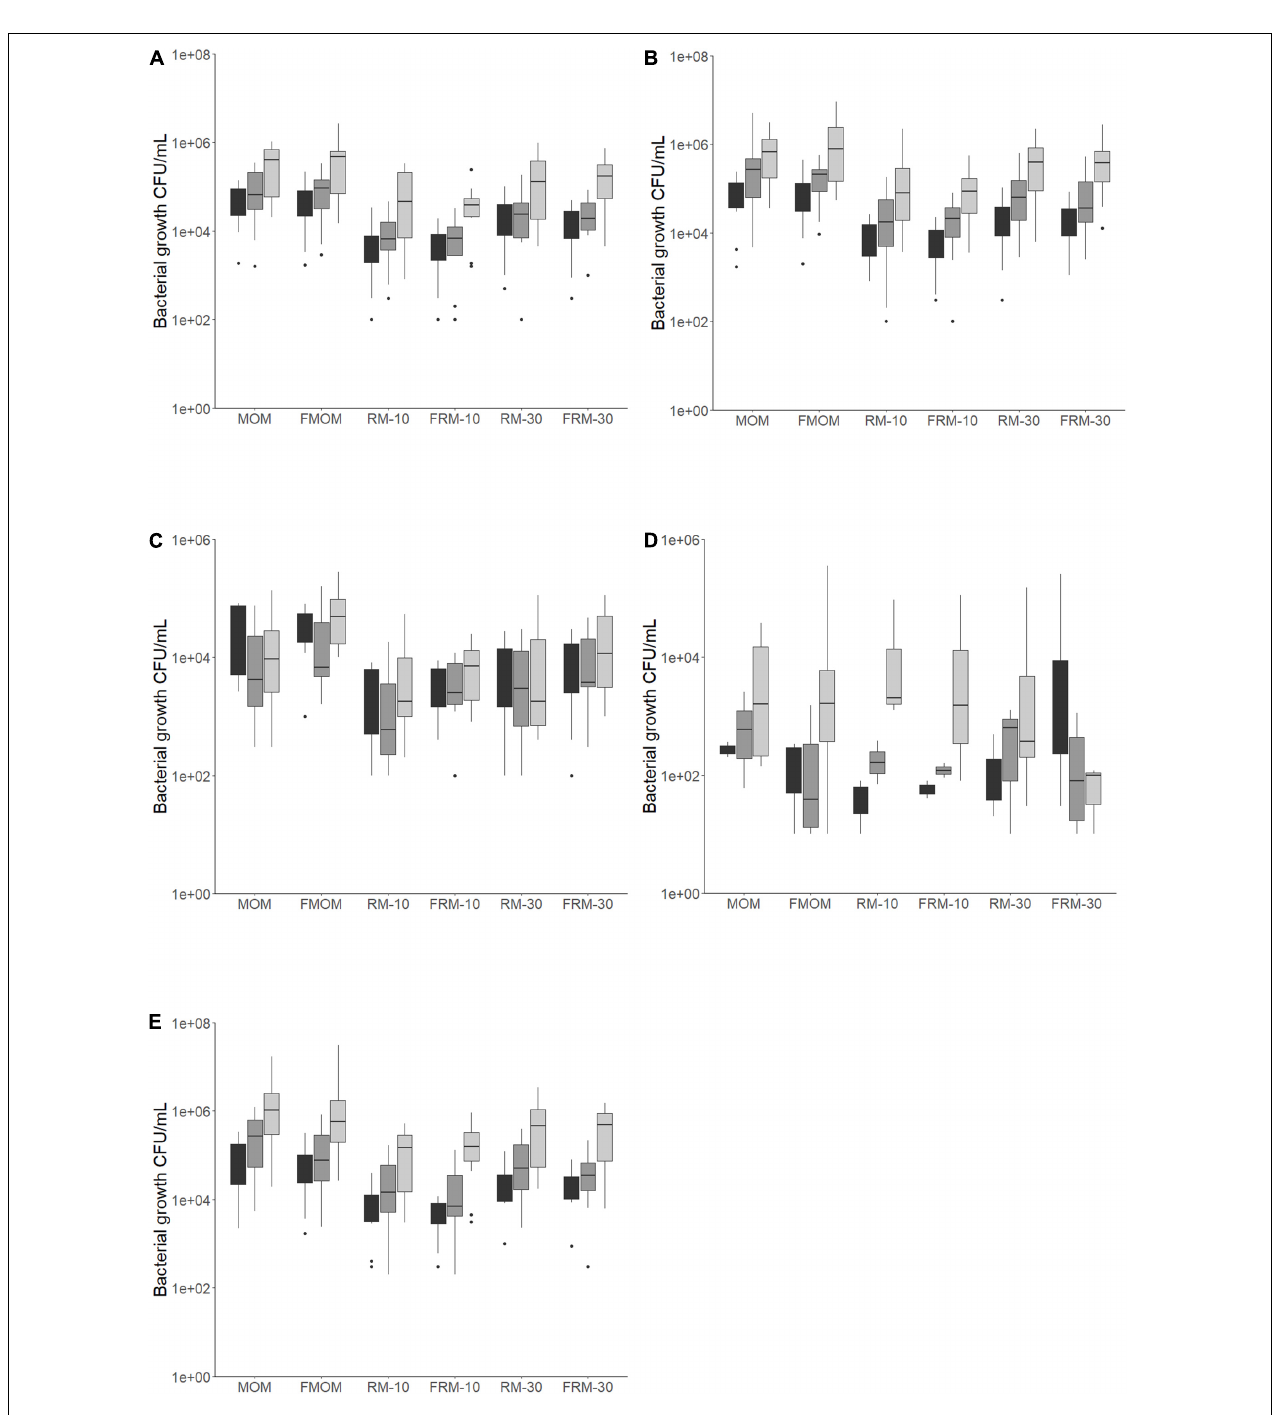
FIGURE 1 | Bacteria load for each milk and personalized DHM samples (MOM, FMOM, RM10, FRM10, RM30, and FRM30) in different types of media at time = 0 (T0, black boxes) and incubated over 2 h (T2, gray boxes) and 4 h (T4, light gray boxes) at 37 ◦ C. (A) CFU/mL in nutrient agar media; (B) CFU/mL in mannitol salt agar media; (C) CFU/mL in MRS agar media; (D) CFU/mL in MacConkey agar media; (E) TSA 5% blood agar media. FMOM, frozen MOM samples; FRM10, frozen RM10 samples; FRM30, frozen RM30 samples; MOM, fresh MOM samples; RM10, fresh RM10 samples; RM30, fresh RM30 samples.